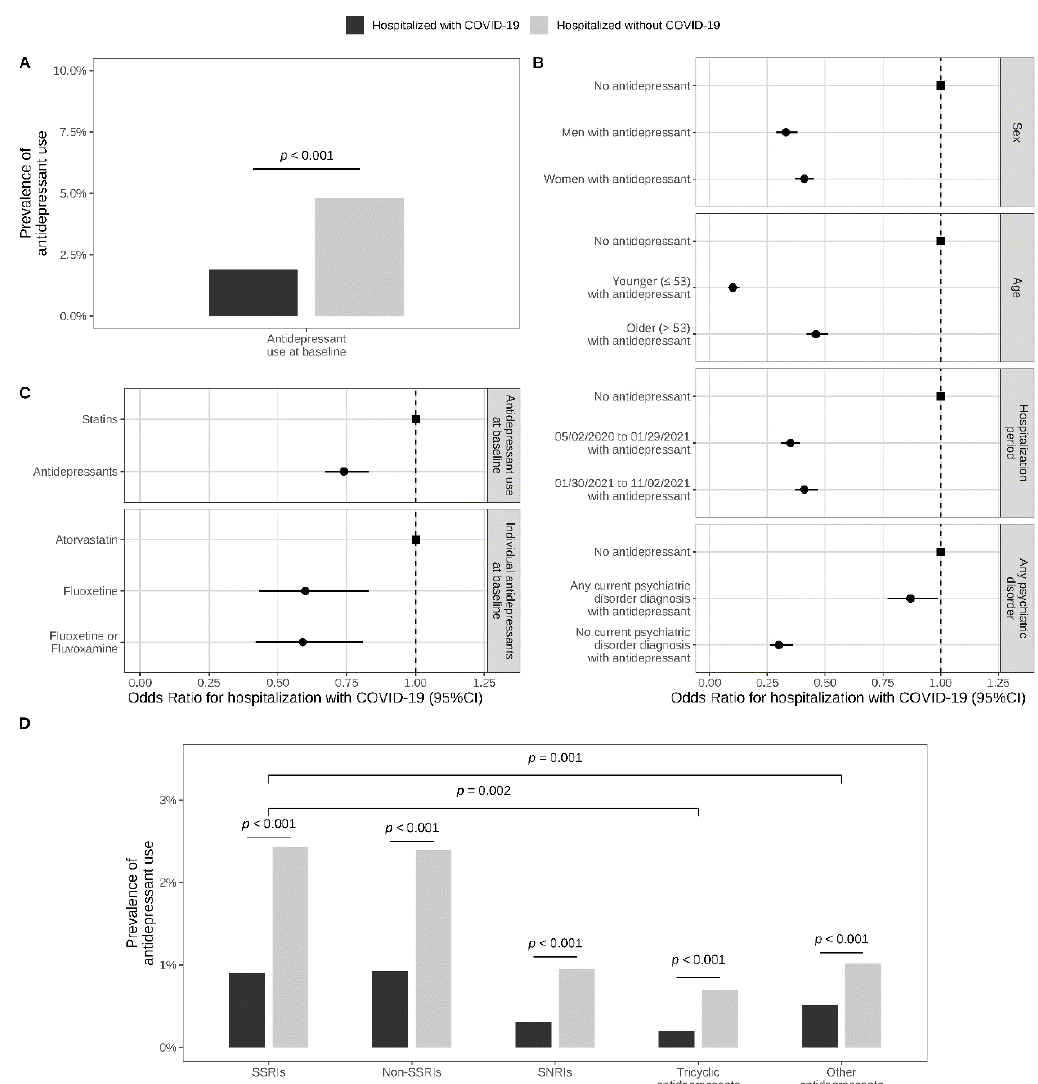
Figure 2. Prevalence of antidepressant use in inpatients hospitalized with and without COVID-19 (N = 82,586). ( A ) prevalence of antidepressant use in a matched analytic sample of inpatients with and without COVID-19, based on age, sex, hospital, period of hospitalization, and number of med- ical conditions; ( B ) association between antidepressant use and SARS-CoV-2 infection in a matched analytic sample of inpatients with and without COVID-19, stratified by age, sex, period of hospital- ization, and any current diagnosis of psychiatric disorder; ( C ) comparison of antidepressant use with statin use, and fluoxetine or fluvoxamine use with atorvastatin use, in a matched analytic sam- ple of inpatients with and without COVID-19; ( D ) associations across antidepressant classes.